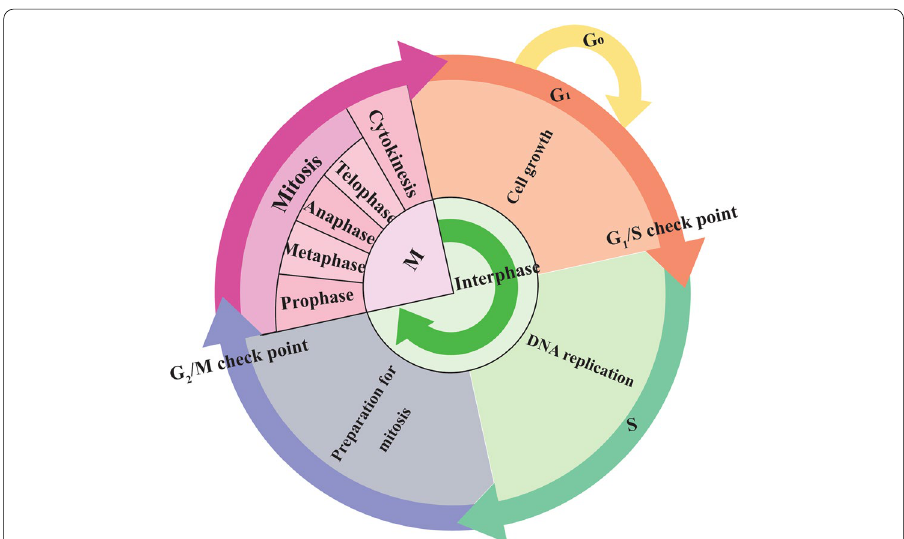
Fig. 3 Different phases of the cell cycle and corresponding